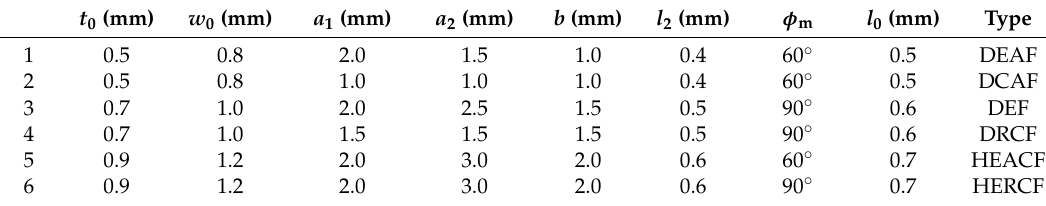
Figure 10. Two-axis elliptical-arc-filleted flexure hinge with two rigid links: ( a ) Finite element mesh model; ( b ) Path definitions. Table 1. Geometric parameters of two-axis corner-filleted flexure hinges with two rigid links.